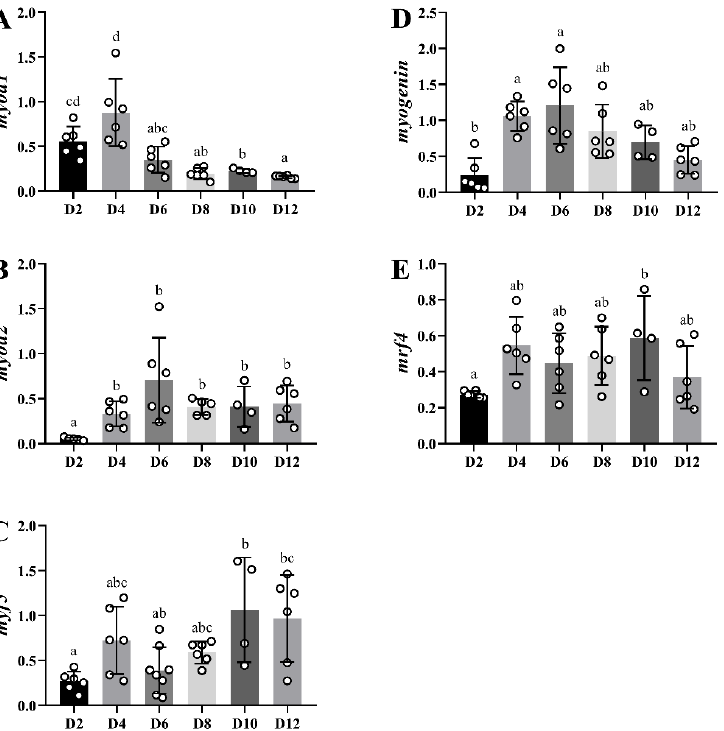
Figure 9. Bar plots of relative gene expression of myod1 ( A ), myod2 ( B ), myf5 ( C ), myogenin ( D ) and mrf4 (E) along the primary culture of myoblasts.White-filled circles represent individual relative gene expression values. Data are presented as means ± SEM ( n = 6). Different letters indicate significant differences ( p < 0.05).